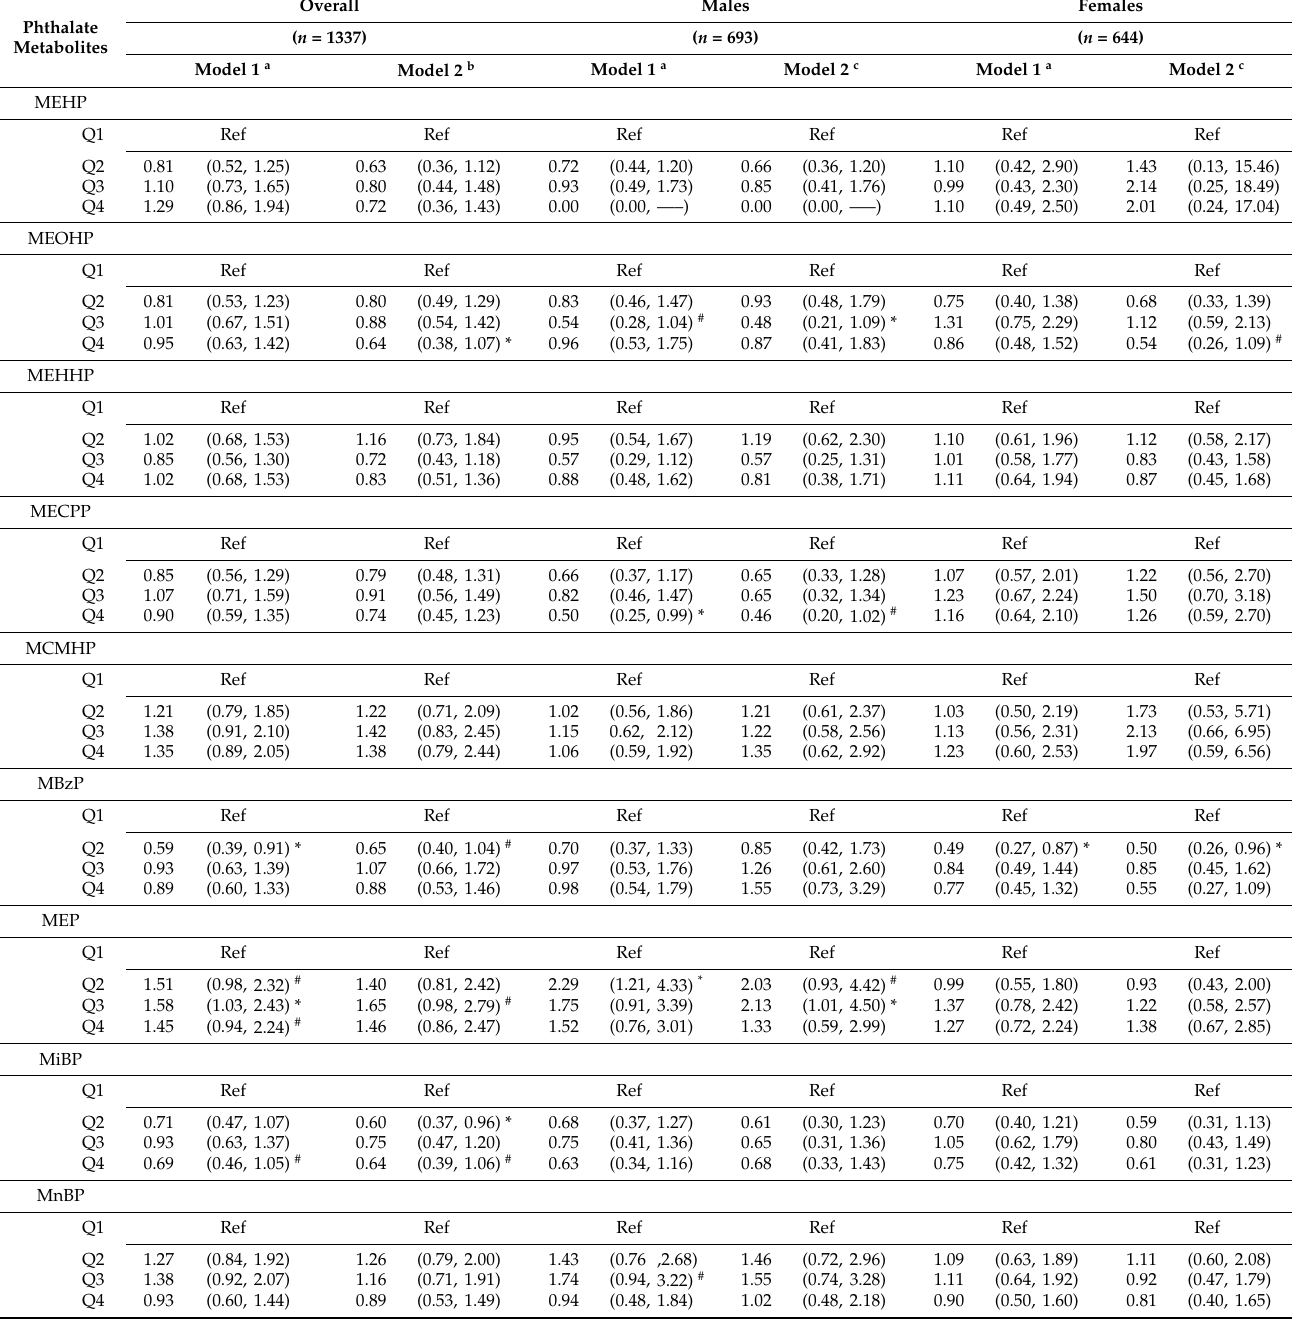
Table 3. Prevalence odds ratios and 95% confidence intervals for metabolic syndromes in males and females based on urinary phthalate